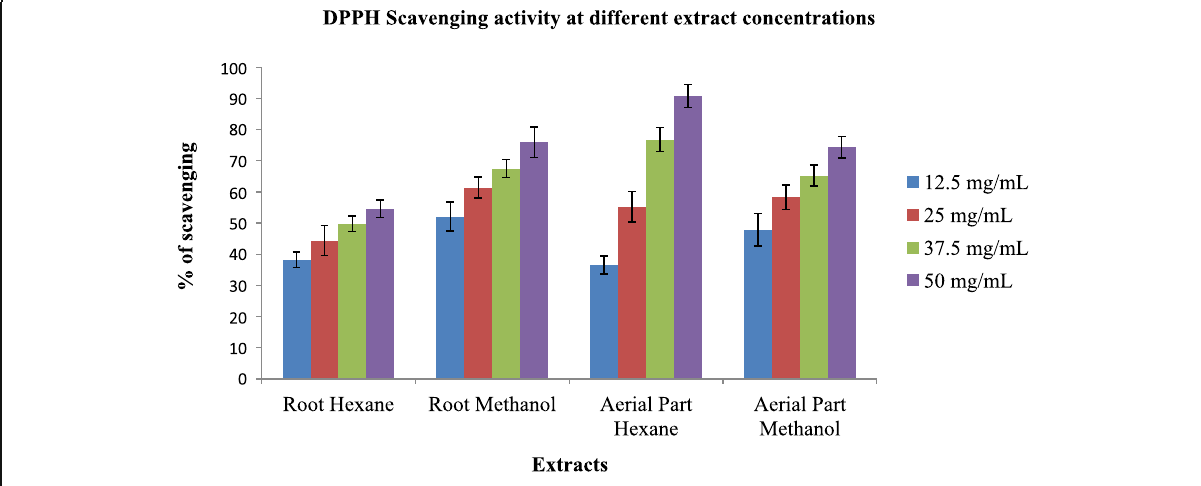
Fig. 1 DPPH scavenging activity of different extracts of V . coriaceum at different concentrations